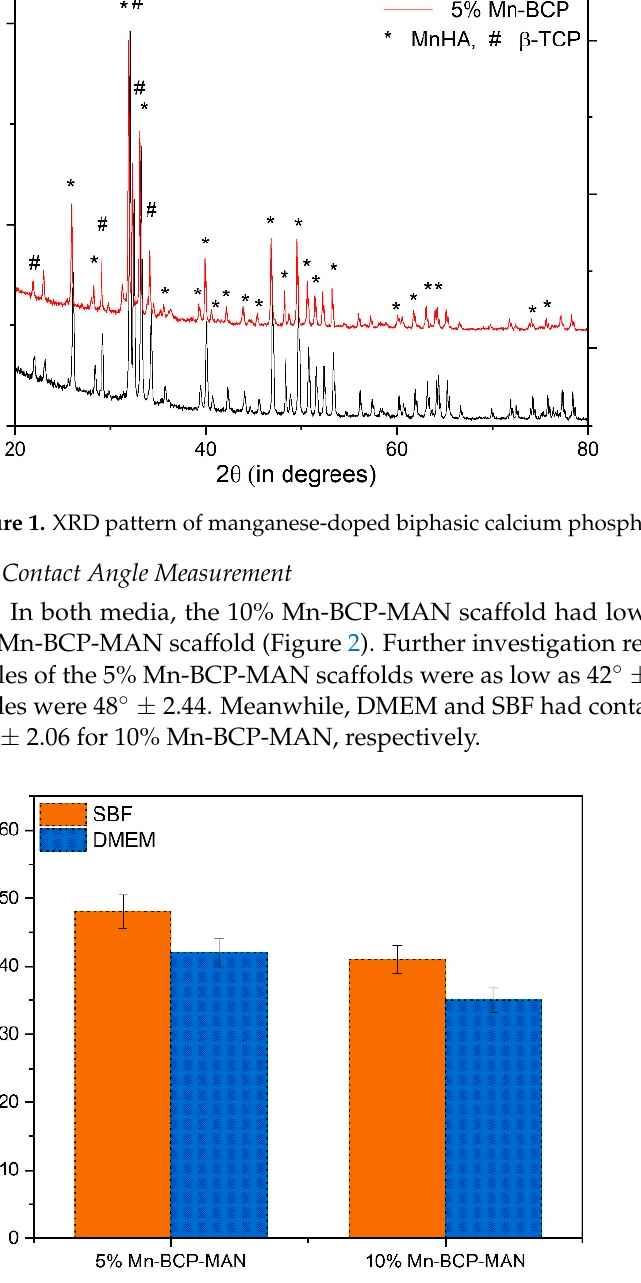
Figure 2. Contact angle of manganese-doped biphasic calcium phosphate scaffolds.